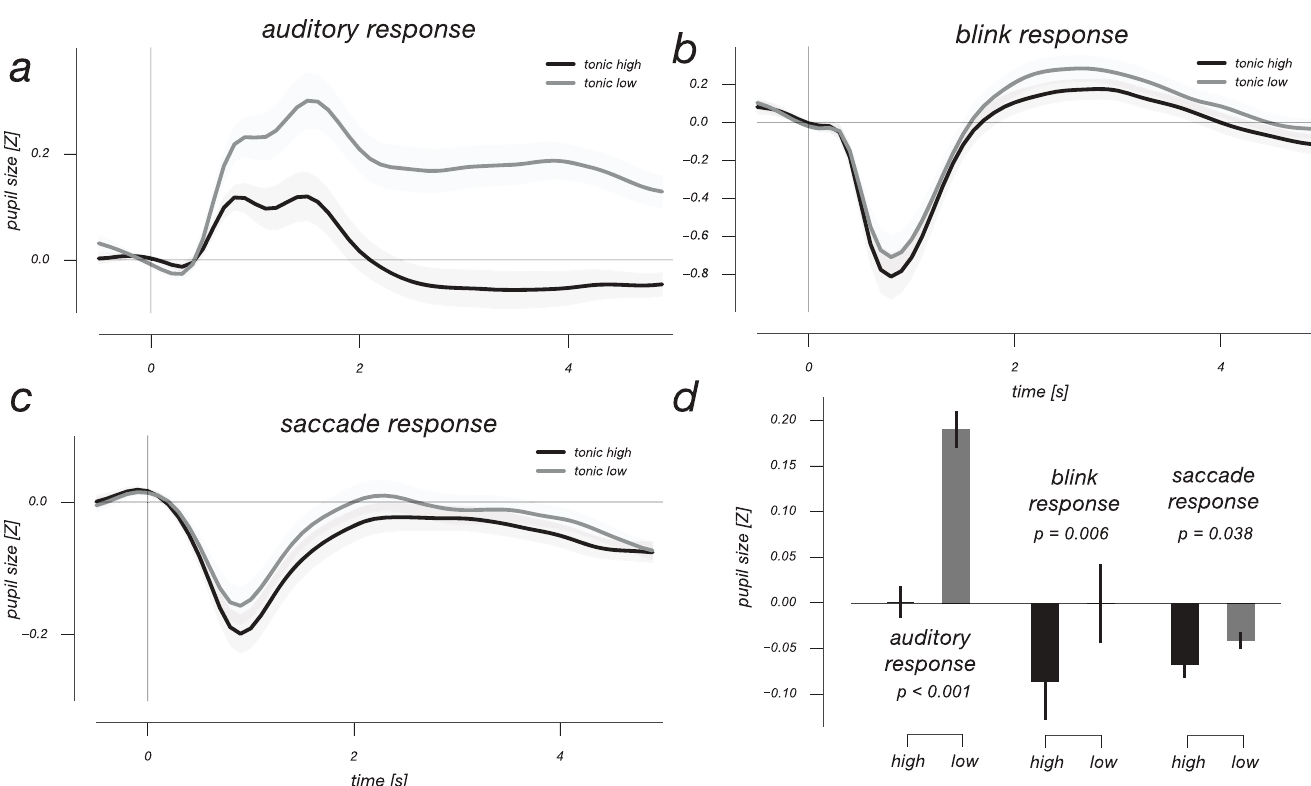
Fig 7. Transient pupil responses are differentially sensitive to tonic pupil size. Events of each type were characterised based on above-median or below-median tonic pupil size. Data were averaged across 4 conditions for auditory, blink and saccade panels a,b,c. The response amplitude and shape of auditory responses changes drastically as a function of tonic pupil size. This effect is evidenced by the bar charts (panel d), showing average responses throughout periods in which the response profiles in question were significant in Figs 1 and 3. For each condition there is a significant scaling due to tonic pupil size, this effect is by far the largest for the ‘ mean ’ response profile, related to the canonical arousal-mediated Response